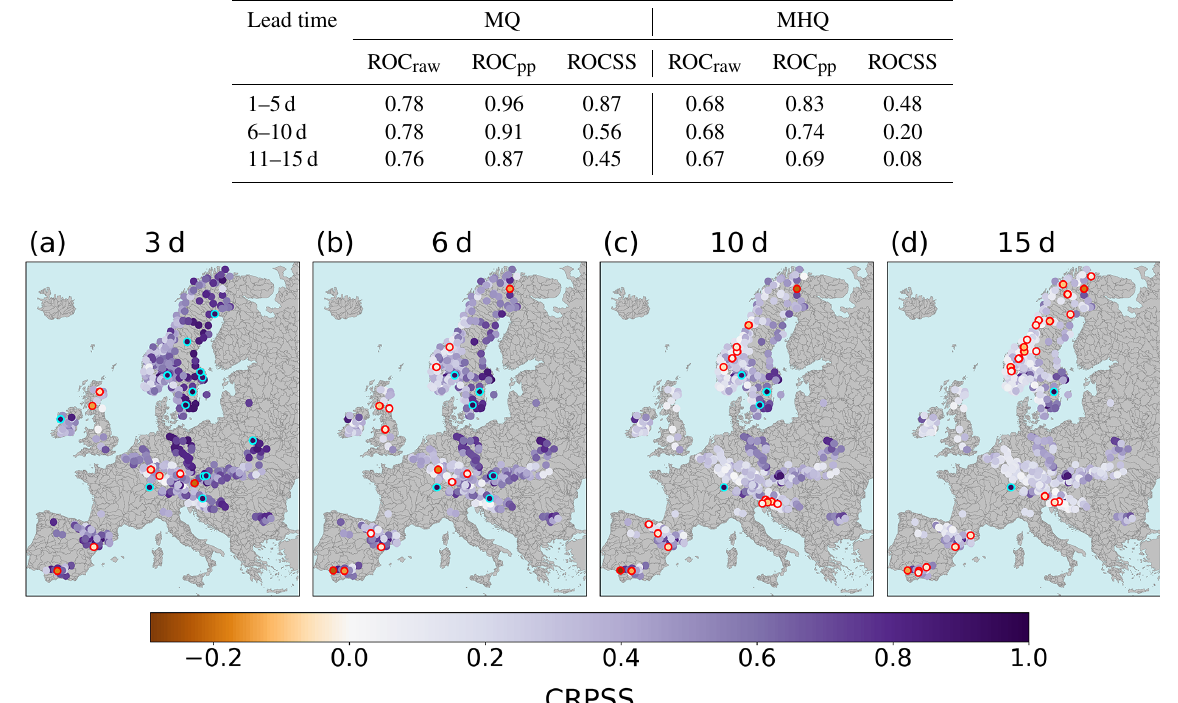
Figure 9. The continuous ranked probability skill score (CRPSS) for all 522 stations for lead times of 3, 6, 10, and 15d. CRPSS values below 0 indicate that the forecast probability distribution is on average less skilful after post-processing and values above 0 indicate added skill after post-processing. Markers are outlined in red if the CRPSS is below 0 and in cyan if the CRPSS is above